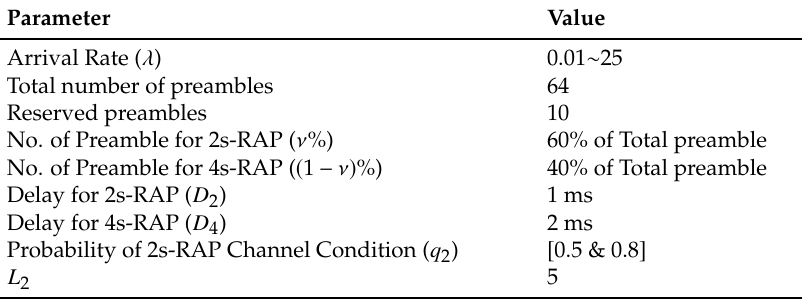
Table 2. Performance